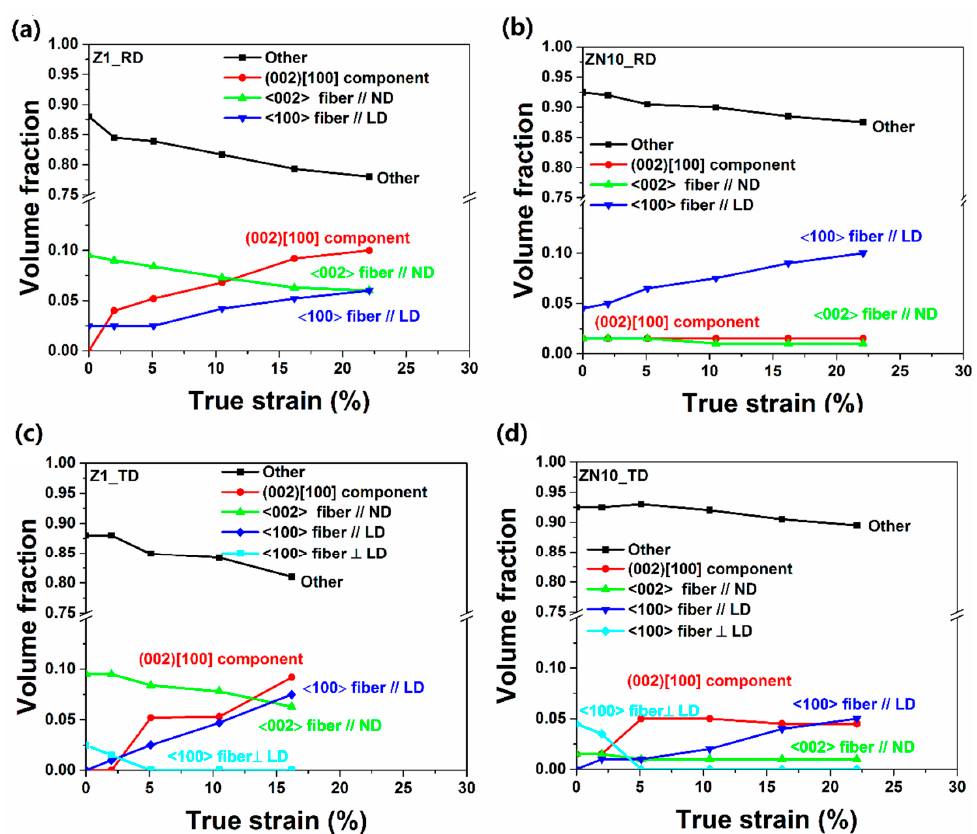
Figure 8. Volume fraction of texture components: ( a ) Z1 in RD; ( b ) ZN10 in RD; ( c ) Z1 in TD; ( d ) ZN10 in TD.